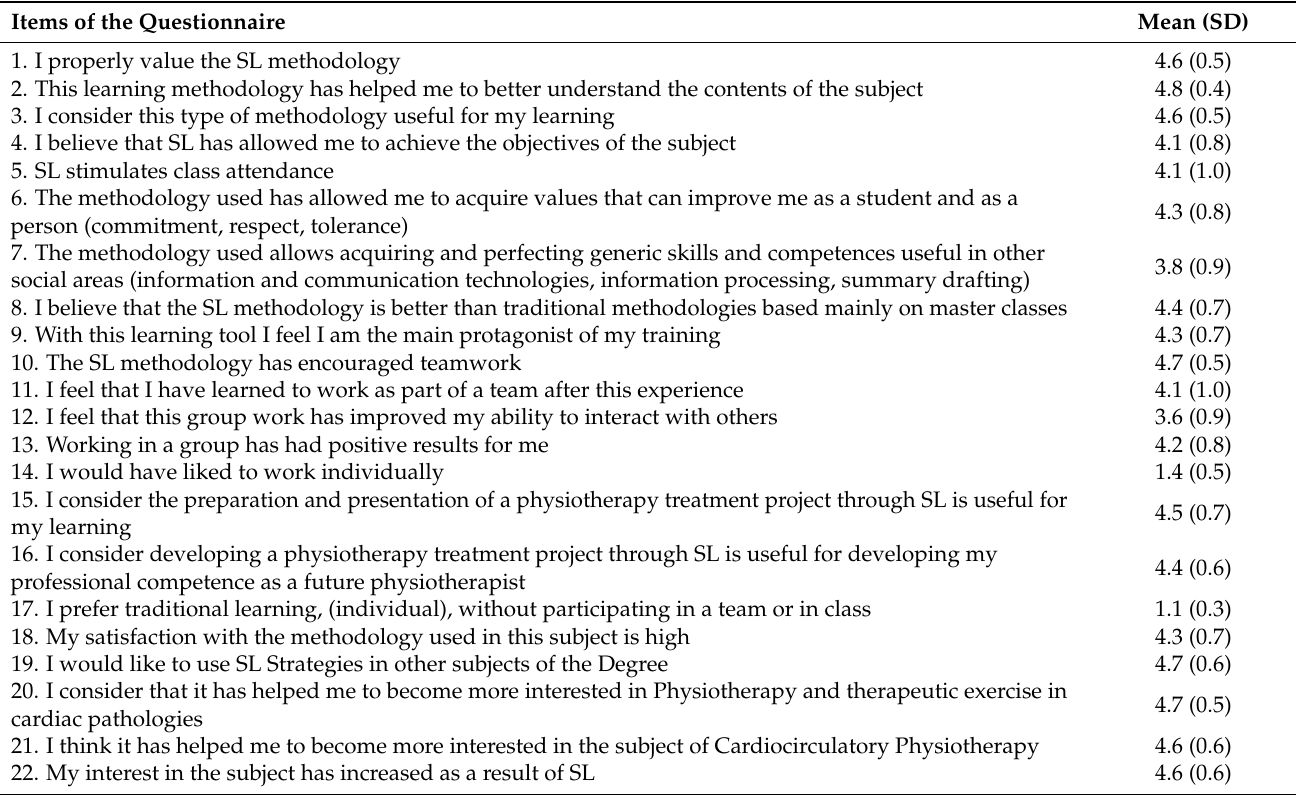
Table 4. Results of the satisfaction questionnaire for the Service-Learning